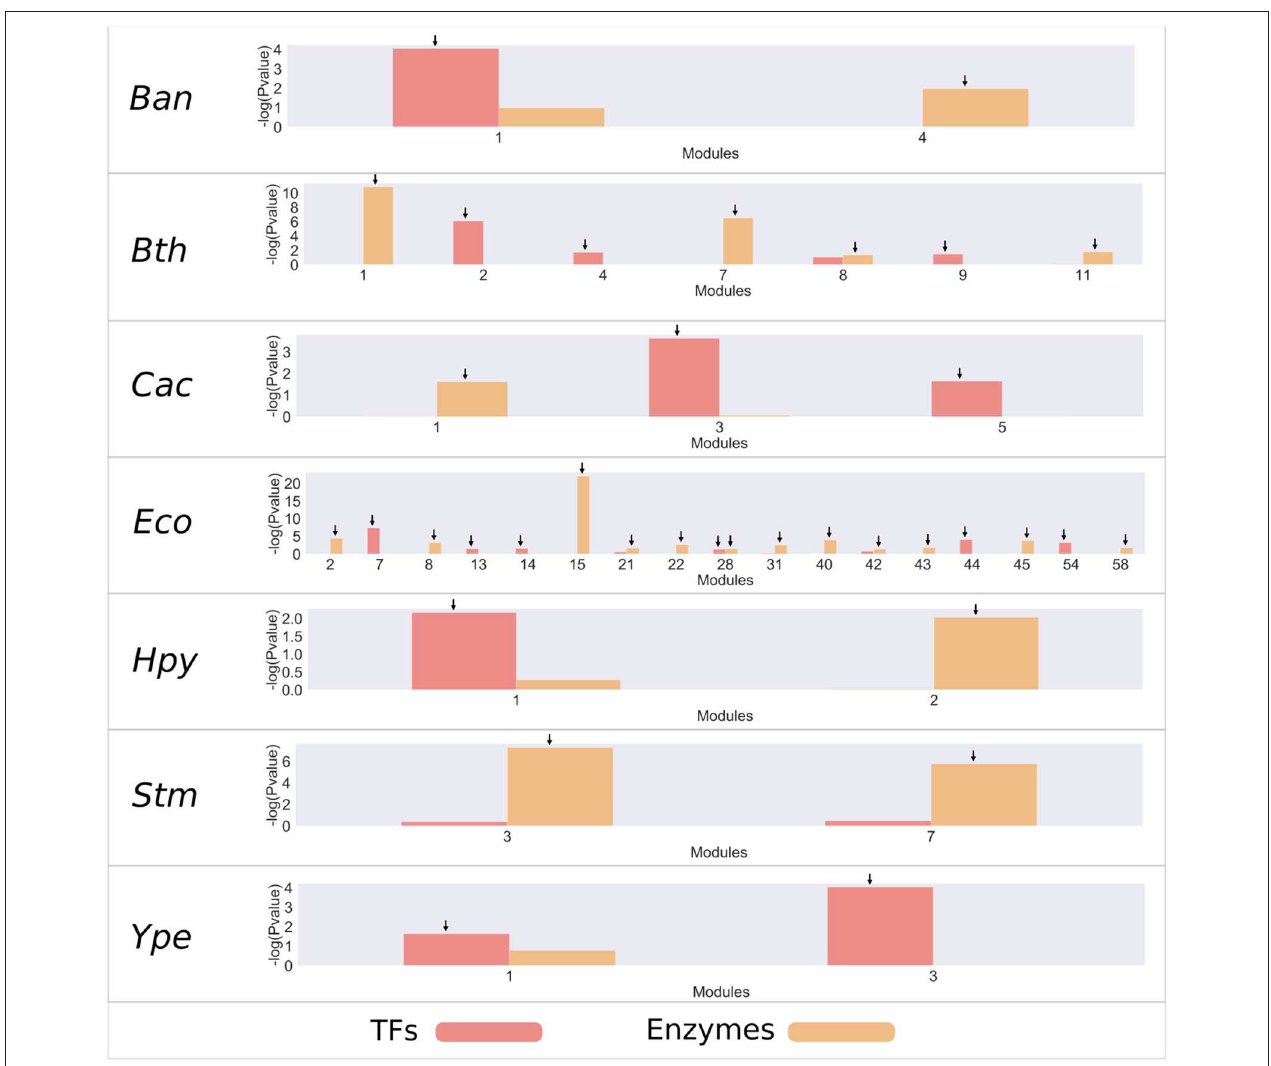
FIGURE 2 | Enrichment of TFs and metabolic enzymes. Modules with a –log10 ( P -value) > 1.5 (corresponding to a P -value < 0.05) were selected as enriched and are indicated by an arrow on the bar. The red bars represent modules enriched with TF families, and the orange bars represent modules enriched with